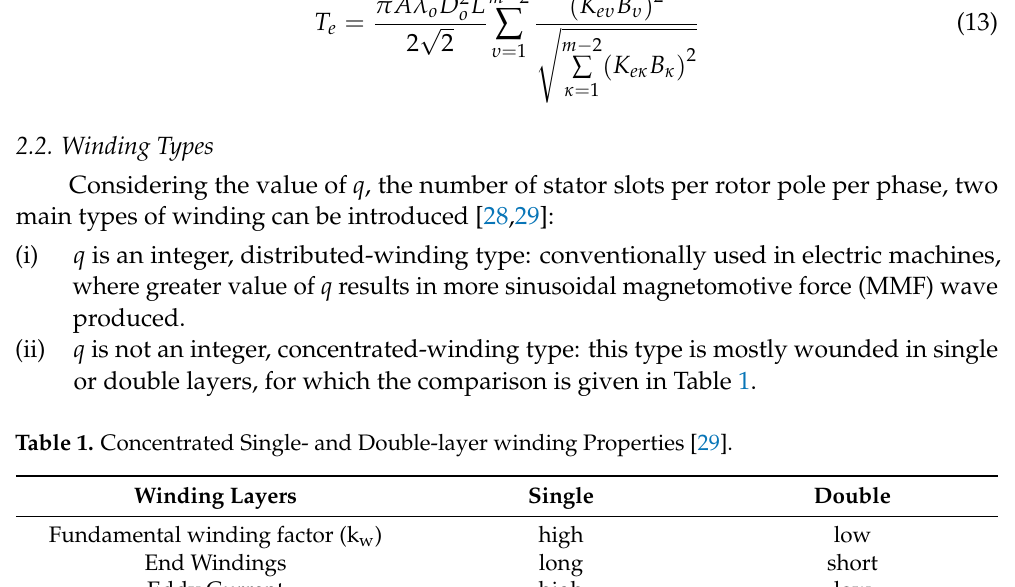
Table 1. Concentrated Single- and Double-layer winding Properties [29]. Winding Layers Single Double Fundamental winding factor (k w ) high low End Windings long short Eddy Current high low Over-load Torque Capability high low Back-EMF Harmonics high low Torque Ripple (T Ripple ) high